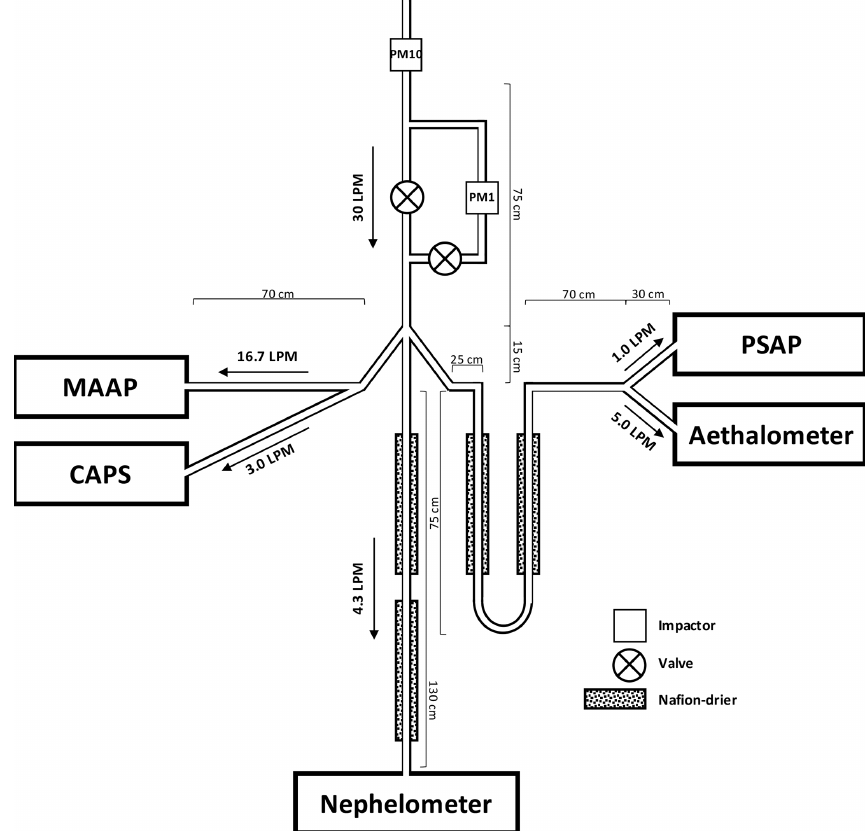
Figure 1. Measurement scheme for the instruments that measured the aerosol optical properties at the SMEAR II station. This setup ran during 2014–2015, when all the instruments were operating in